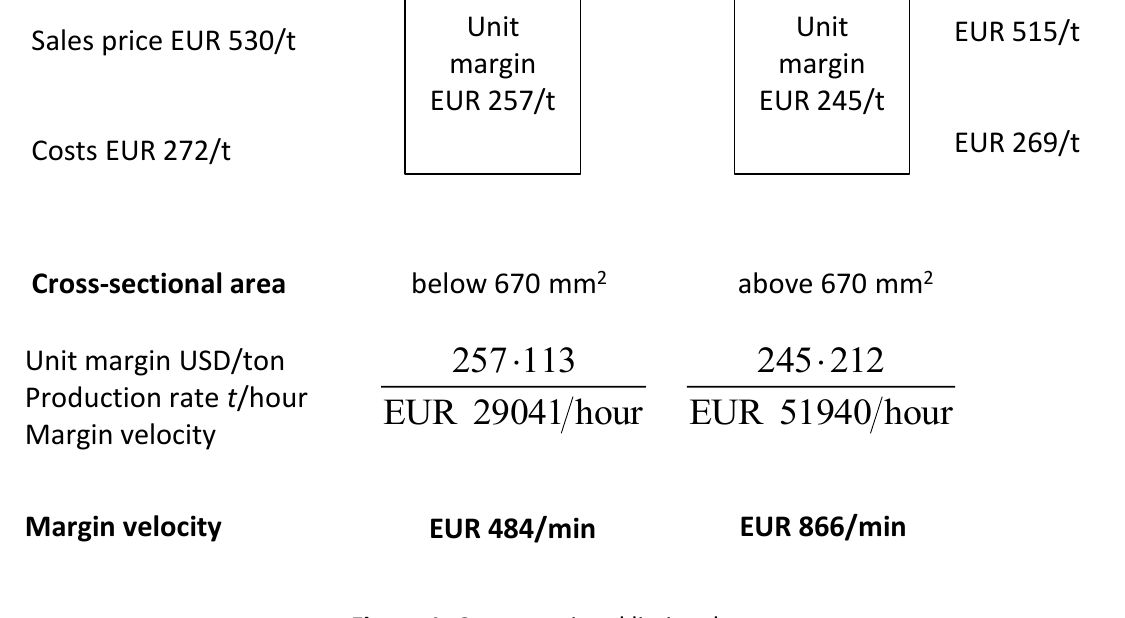
Figure 1. Cross-sectional limit value